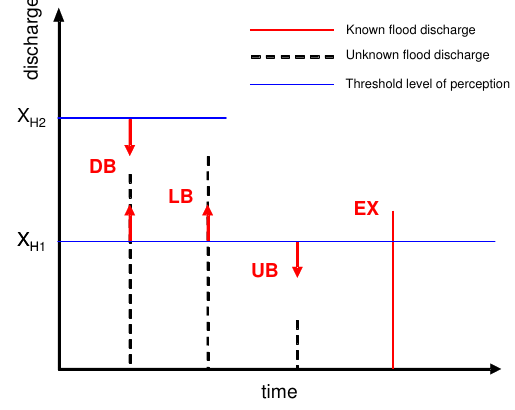
Fig. 1. Proposed flood data classification (after Naulet, 2002), in this figure with two constant X H